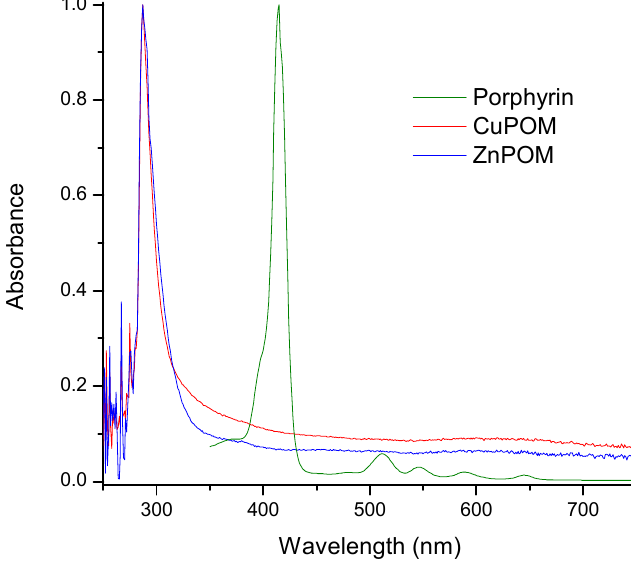
Figure 1. UV-vis spectra of TCPP, CuPOM and ZnPOM.